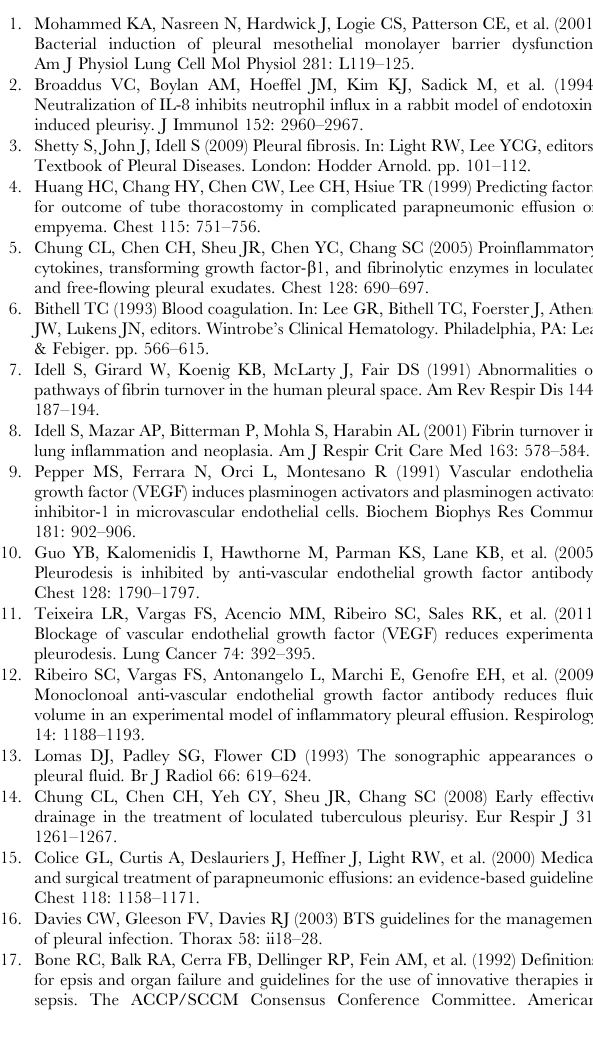
Protocol S2 CXR scoring and validation. Protocol S3 Outcome measures for CPPE (complicated parapneumonic effusion)